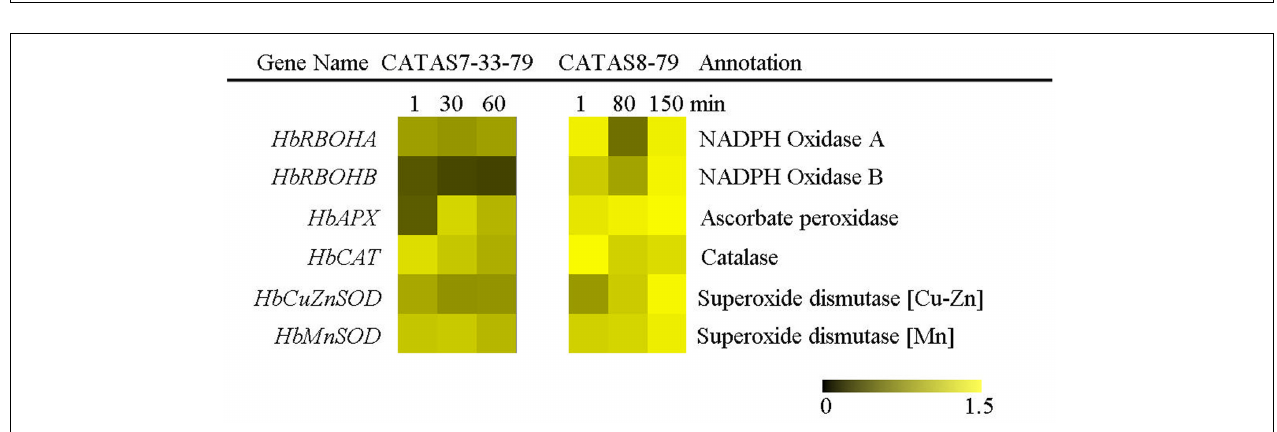
FIGURE 5 | The qRT-PCR analysis of hormone metabolism-related genes across three stages of latex flow between CATAS7-33-97 and CATAS8-79.